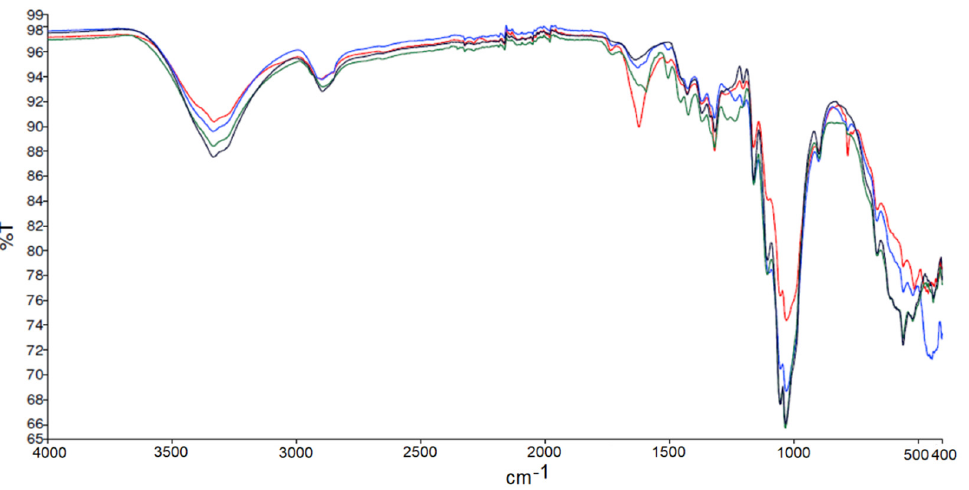
Figure A3. FTIR-ATR overlap of cellulose fractions of all biomasses: Licorice Root (L, red), cellulose Palm Leaf (P, blue), cellulose Willow (W, green) and cellulose Holm Oak (OH,